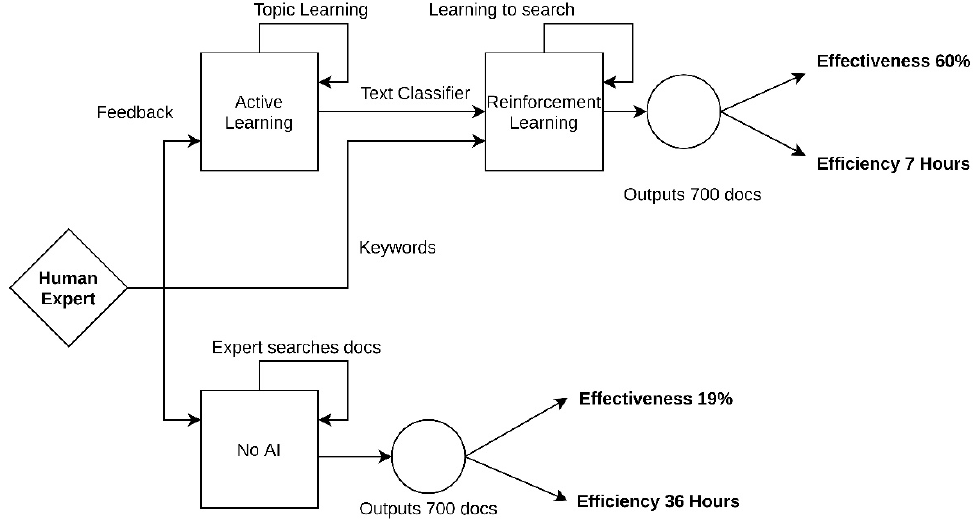
Figure 2. Flow diagram of the experimental method.